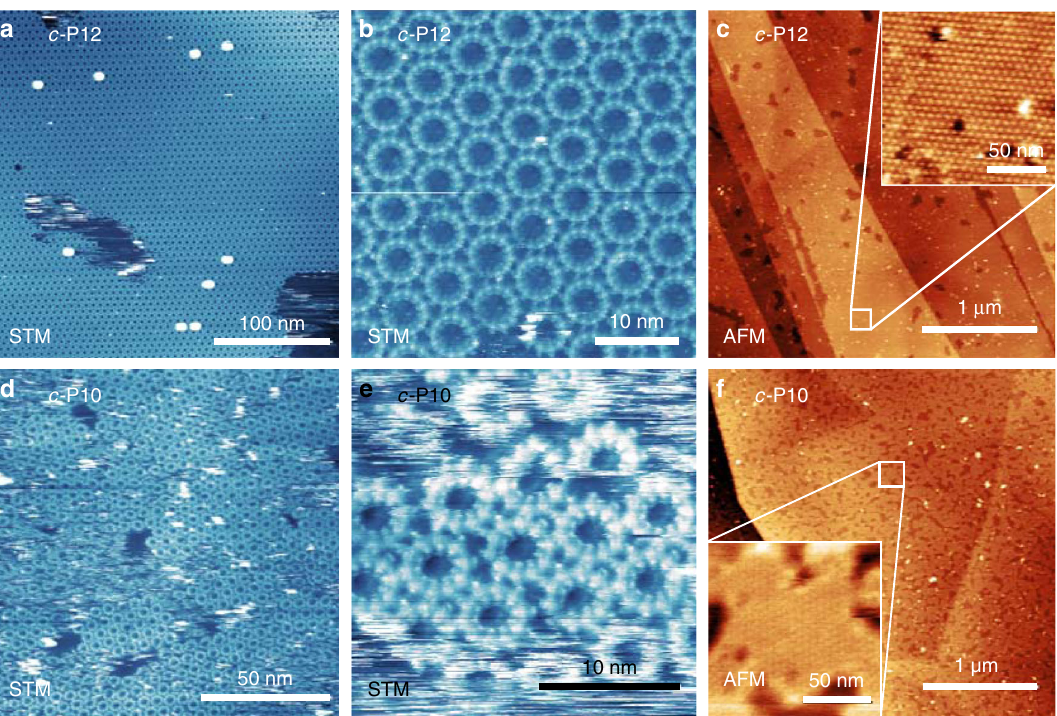
Fig. 2 Scanning probe microscopy (SPM) images of porphyrin nanorings deposited on a highly oriented pyrolytic graphite (HOPG) surface. a Scanning tunnelling microscopy (STM) image of continuous c- P12 domain. The bright spots correspond to stacks of multiple c- P12 rings. b High-resolution STM image showing packing of c- P12 molecules in a single domain. c Atomic force microscopy (AFM) image showing large-scale structure of c- P12 domains on HOPG. Dark regions correspond to voids in the nanoring monolayer. (Inset) High-resolution image showing hexagonal packing of c- P12 molecules in region indicated by the white box in the main image. d STM image of c- P10 domains on HOPG. e High-resolution image of c- P10 molecules. f AFM image showing large-scale structure of c- P10 domains on HOPG. (Inset) High-resolution image of a single c- P10 domain at the region indicated by the white box in the main